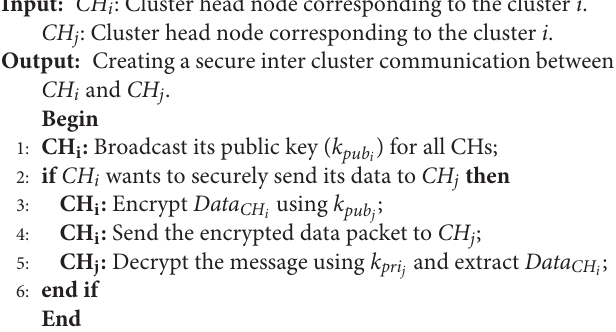
Algorithm 3 : Secure inter-cluster communications.